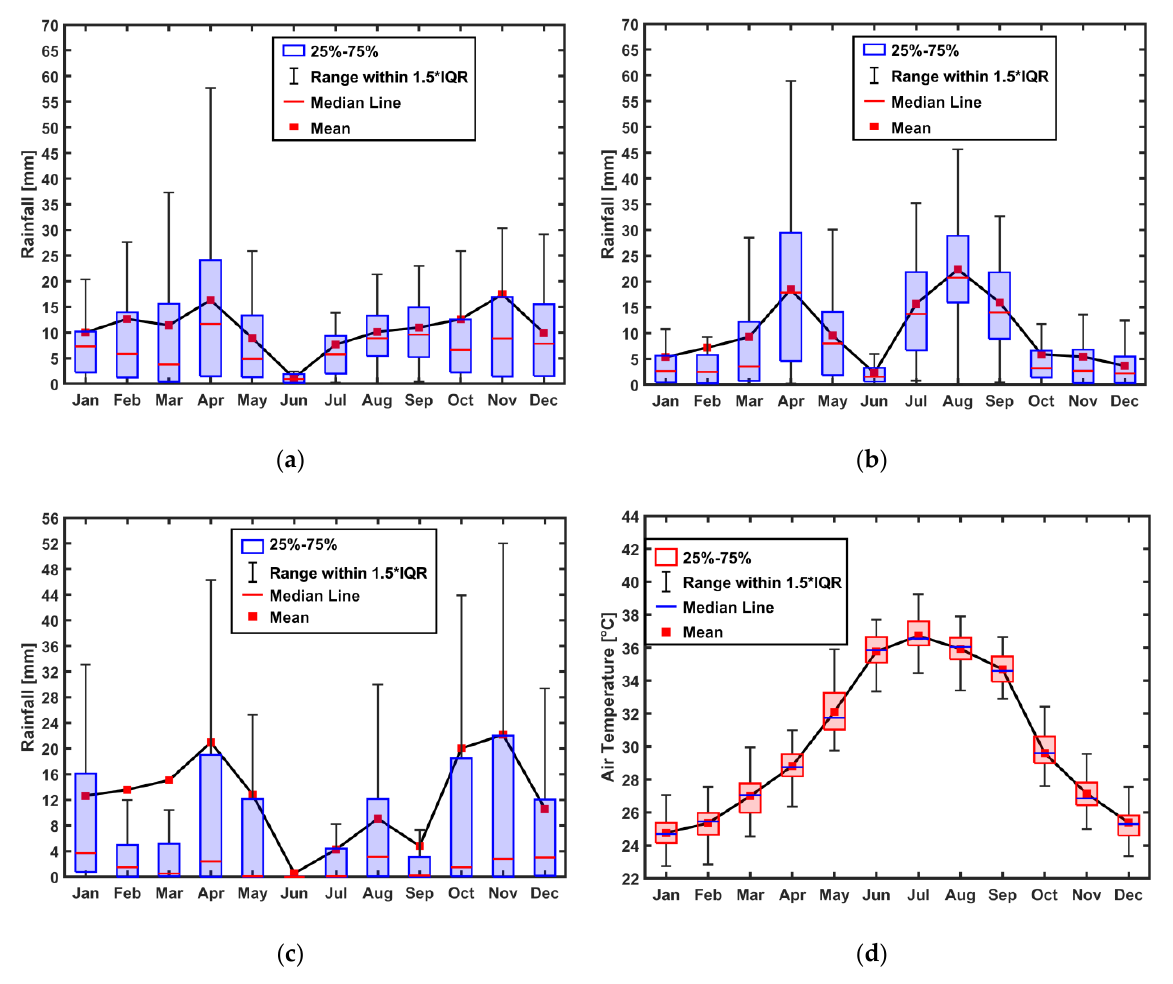
Figure 5. Monthly climatology over the Republic of Djibouti for the period 1961–2021: Panels ( a , b ) indicate the mean monthly precipitation regimes in the EAST and WEST regions, respectively, as presented in Figure 4. The mean monthly rainfall and mean air temperature at the airport station are presented in panels ( c , d ), respectively.